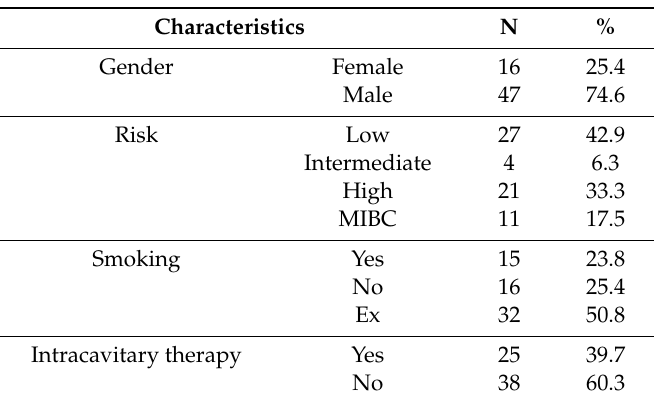
Table 1. Patients’